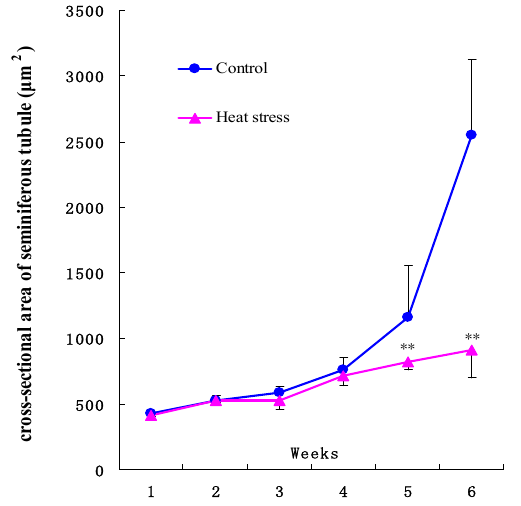
Figure 5. Effects of HS on the cross-sectional area of seminifer- ous tubule in chicks ( n = 6). Note: compared between CK and HS groups at the same age. ∗∗ P < 0 .